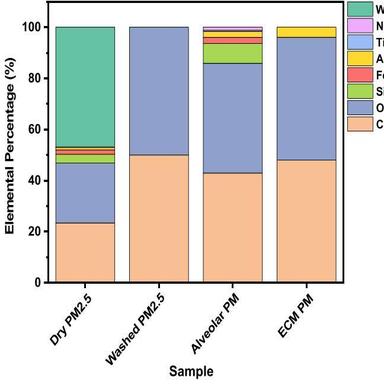
Weight percentage of elements in the PMs structure.